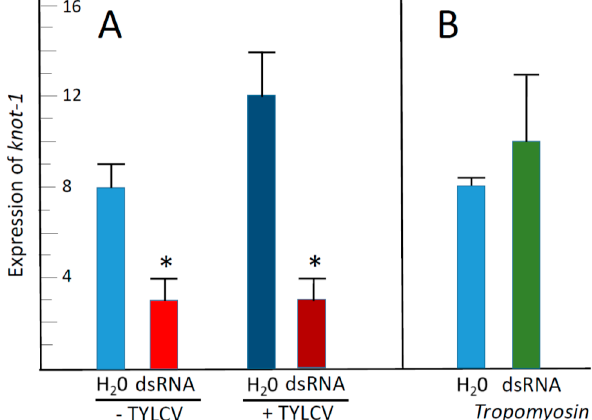
Figure 5. Effect of TYLCV acquisition on the expression of knot ‐ 1 ; in whiteflies with and without silenced knot ‐ 1 . ( A ) qPCR quantification of knot ‐ 1 transcript levels in adult whiteflies after caging the insects for 48 h with tomato bathing in water (H 2 O) or in knot ‐ 1 dsRNA (dsRNA); before ( − TYLCV) and after caging with infected tomato leaflets (+ TYLCV) for a 48 h virus acquisition ( n = 3; mean ± SEM). ( B ) knot ‐ 1 expression in whiteflies following caging the insects for 48 h with tomato bathing in water (H 2 O) or in tropomyosin dsRNA (dsRNA tropomyosin ) ( n = 3; mean ± SEM). An asterisk above the bars indicates significant differences between treatments at p < 0.05.